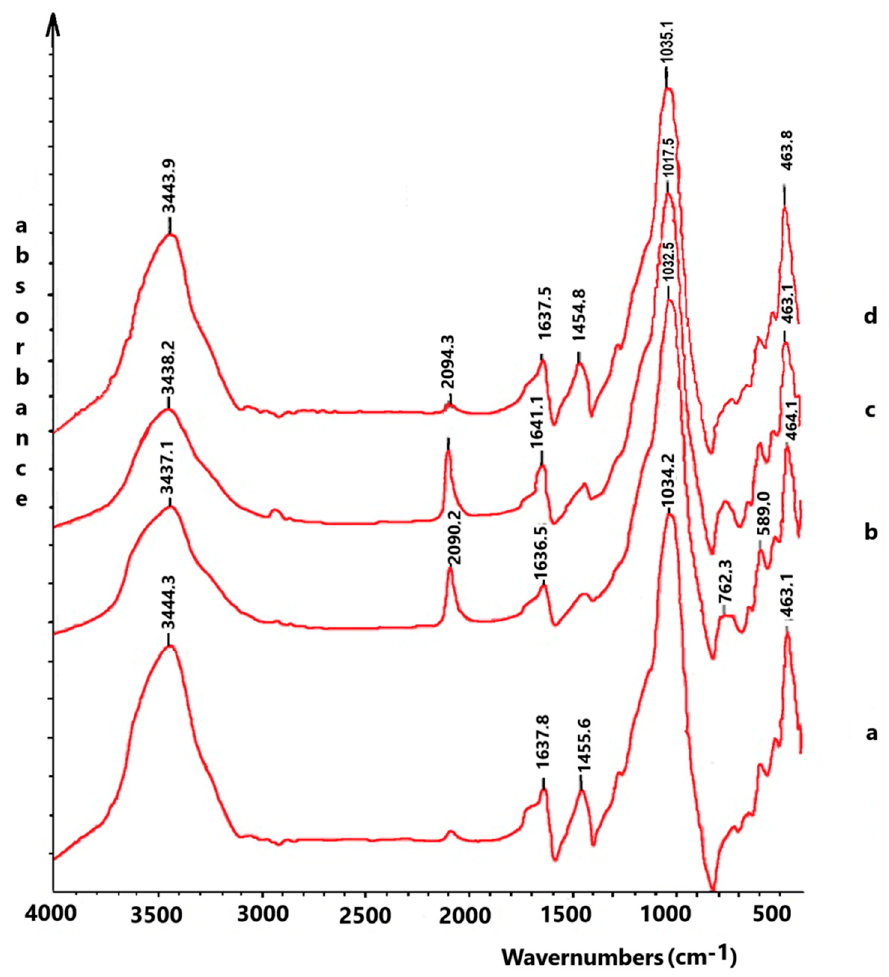
Figure 4. TheIR spectra of zeolites. Zeolites: a—natural; with the maximum content of cations: b and c—In 3+ and Ga 3+ ; d—with the minimum content of the In 3+ and Ga 3+ cations.